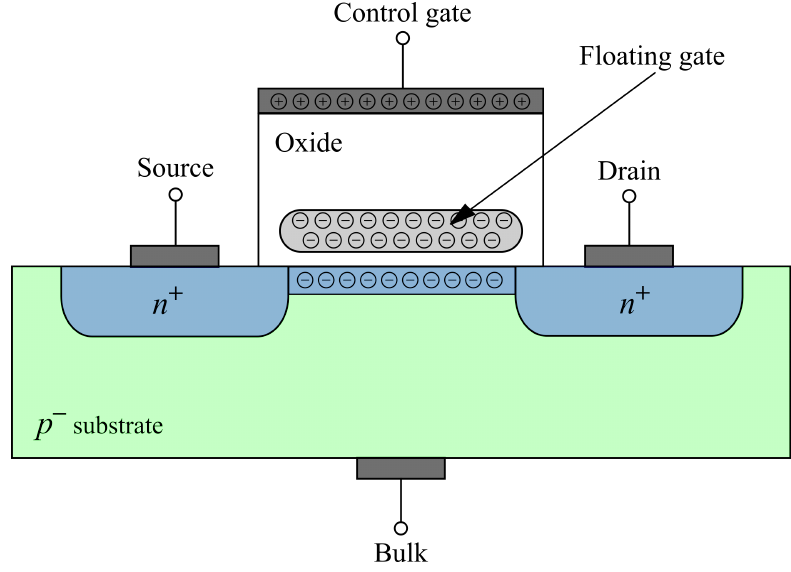
Figure 1. MOS transistor with the charged floating